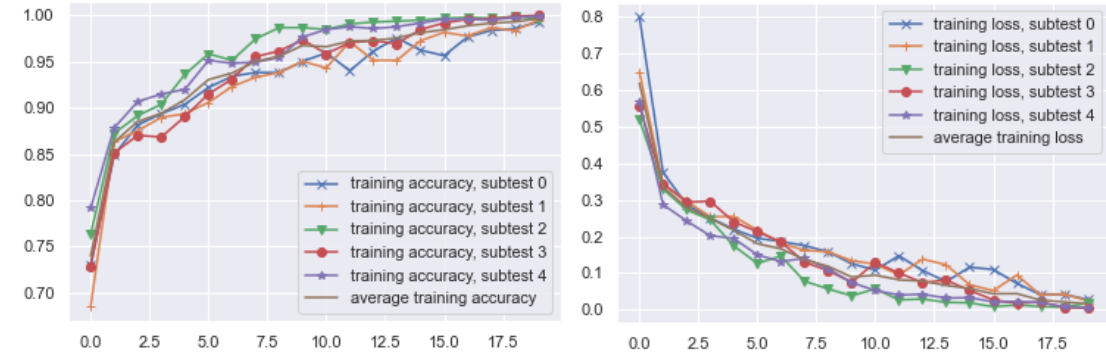
Figure 8. Class 0 vs. Class III. Model: the LeNet model from Figure 5 was applied. Validation technique: cross-validation 5. Accuracy for 20 iterations of neural network training and corresponding cross-entropy loss.